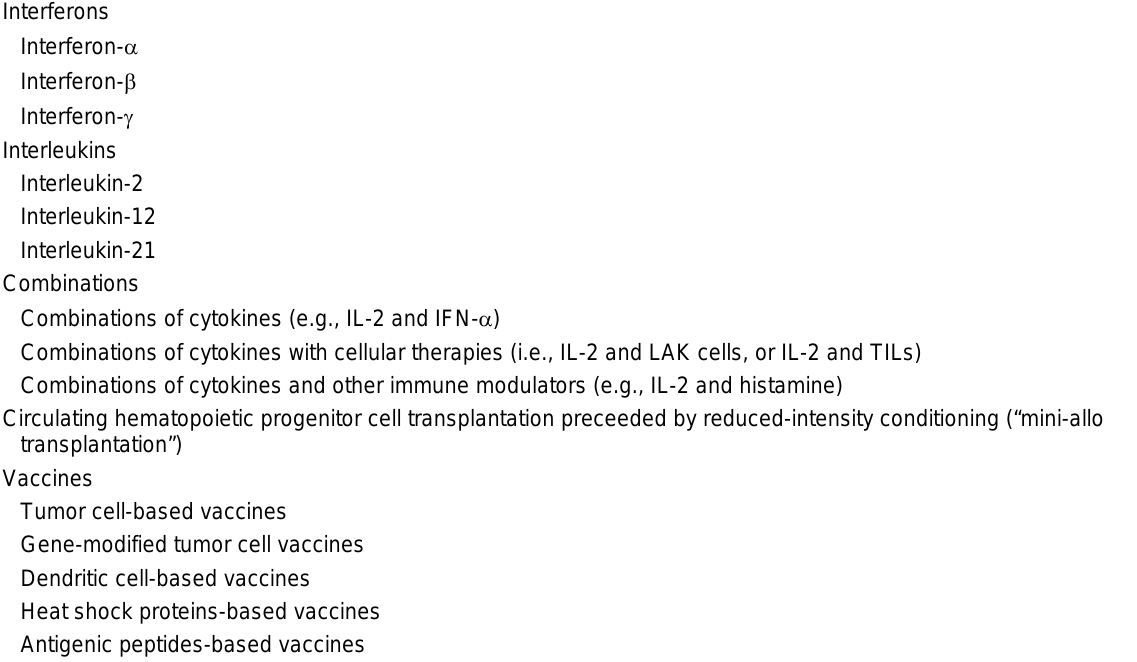
Different Immunotherapeutic Approaches for Advanced